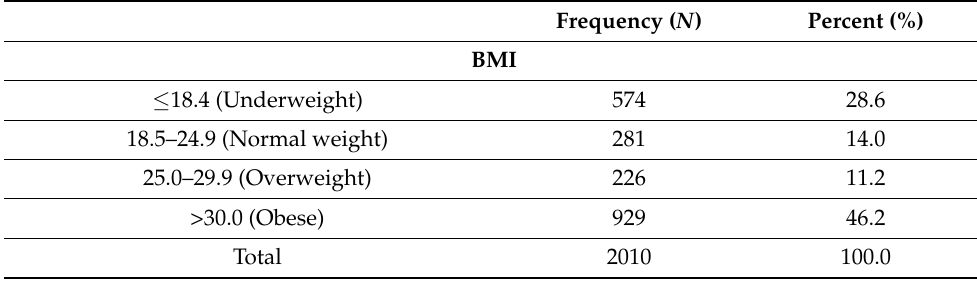
Table 3. Categorical distribution of anthropometric